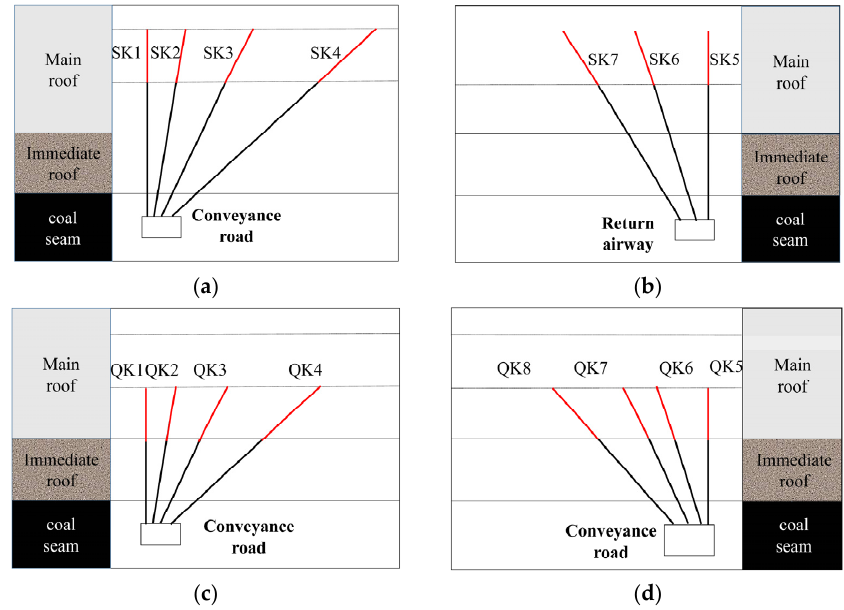
Figure 10. The schematic diagram of pre-splitting blasting at high position and shattering at low